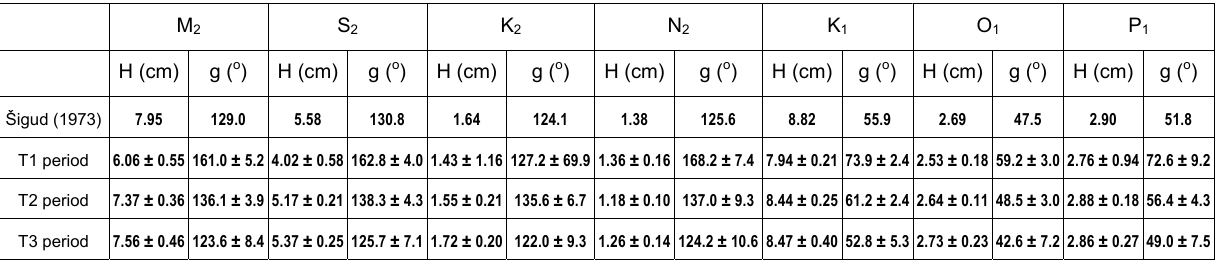
M 2 S 2 K 2 N 2